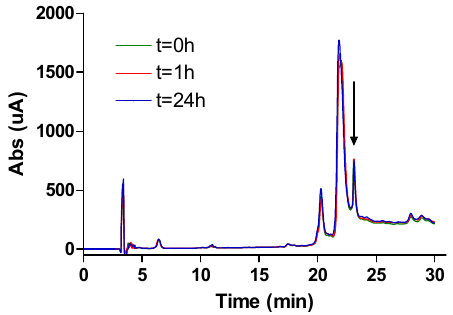
Figure 10. Serum stability of compound 11 evaluated in human plasma (See Supporting Information).